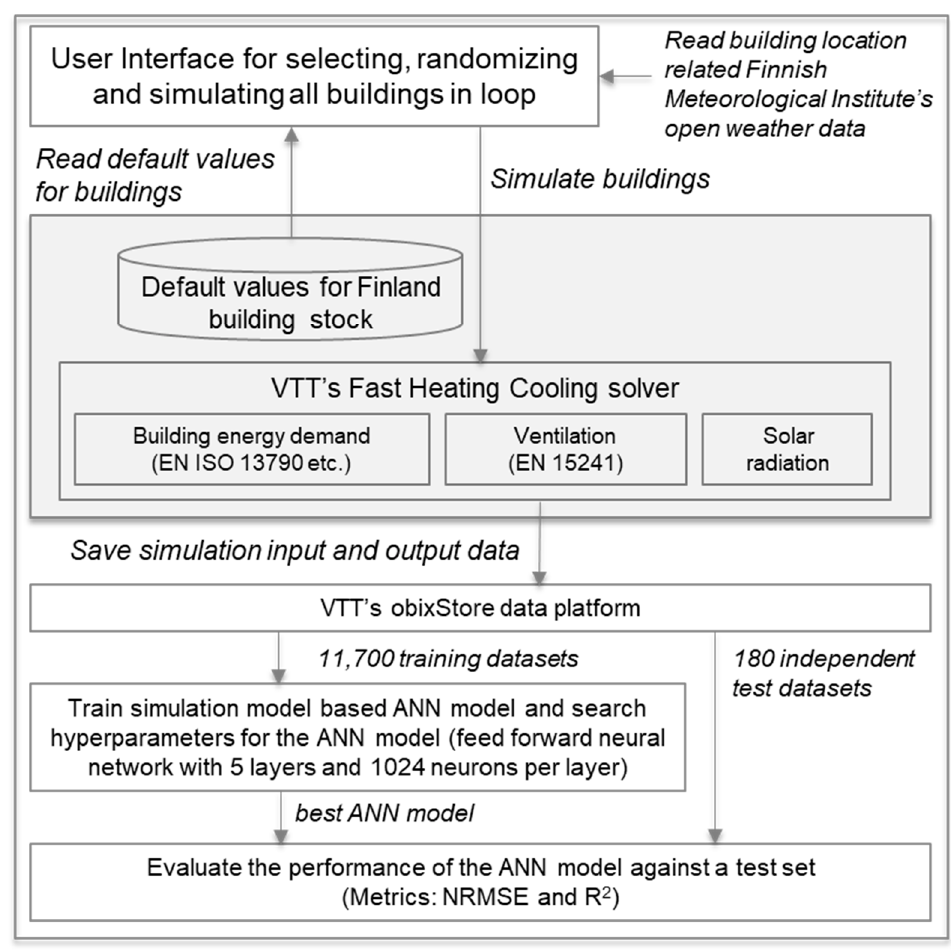
Figure 1. An overview of the approach and methodology.